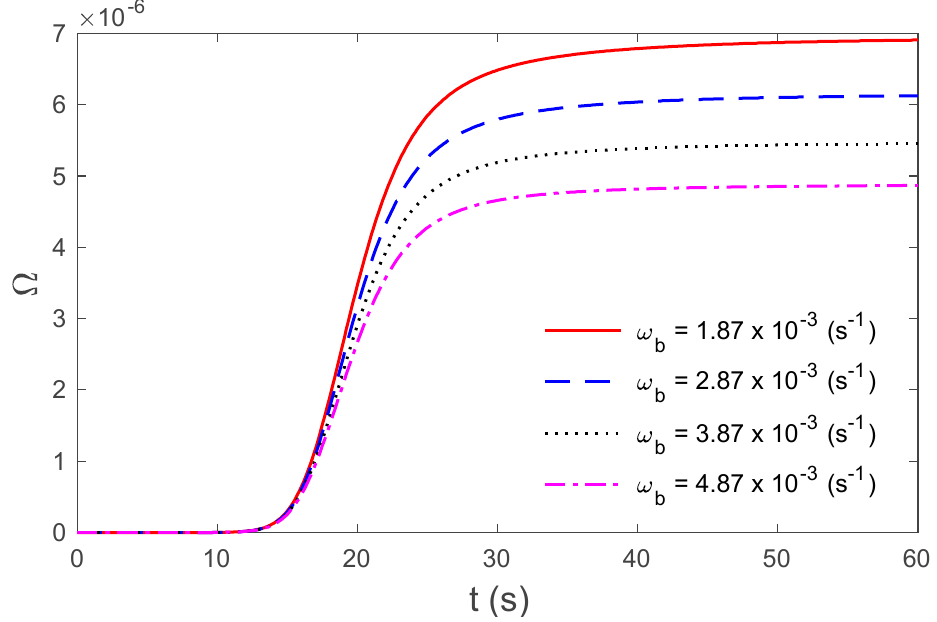
Figure 7. Variations in thermal damage under the TPL model for several values of the rate of blood perfusion 𝜔 (cid:3029) at the skin surface 𝑥 = 0 .